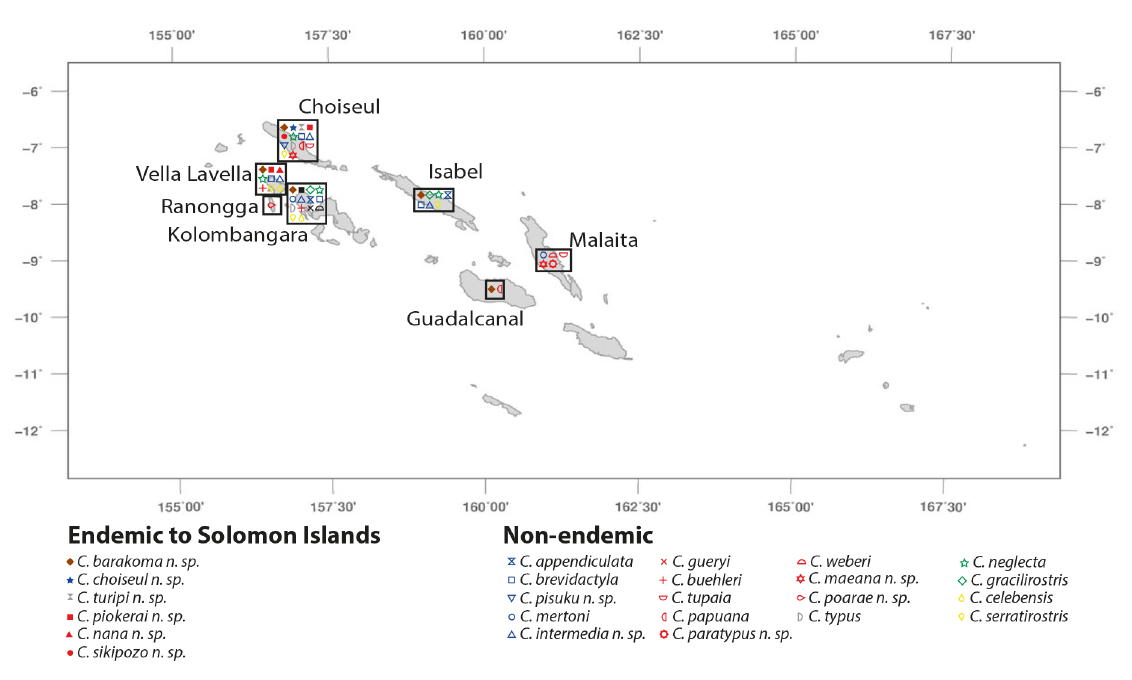
Fig. 1. Distribution of the species studied in the Solomon Islands. Symbols are colored according to the different species complexes (see Fig. 2): brown for C. brevicarpalis complex, blue for C. nilotica complex, red for C. weberi complex, grey for C. typus complex, green for C. gracilirostris complex and yellow for C. serratirostris